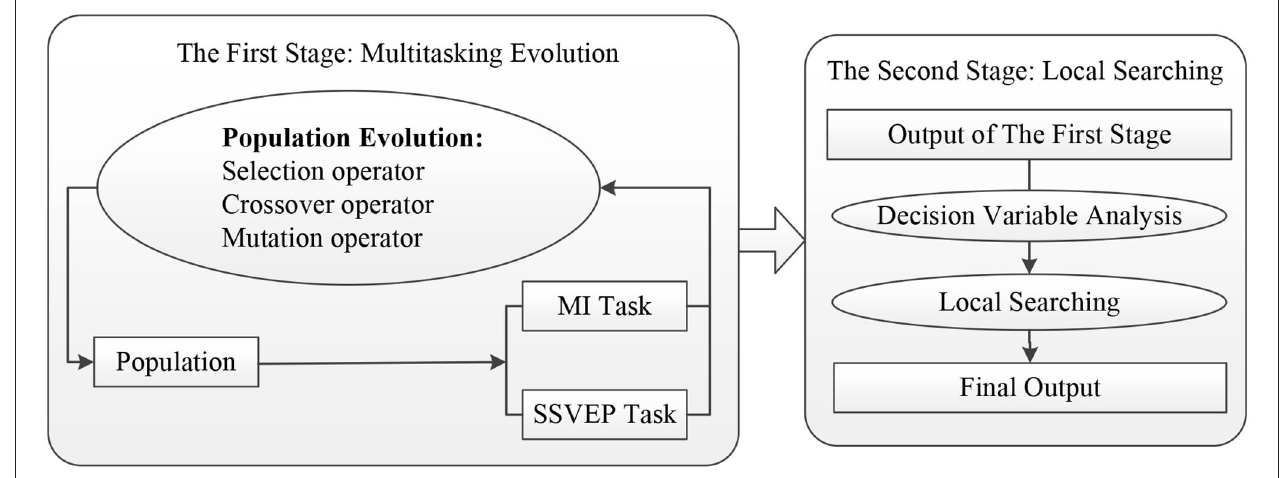
FIGURE 2 | Framework of